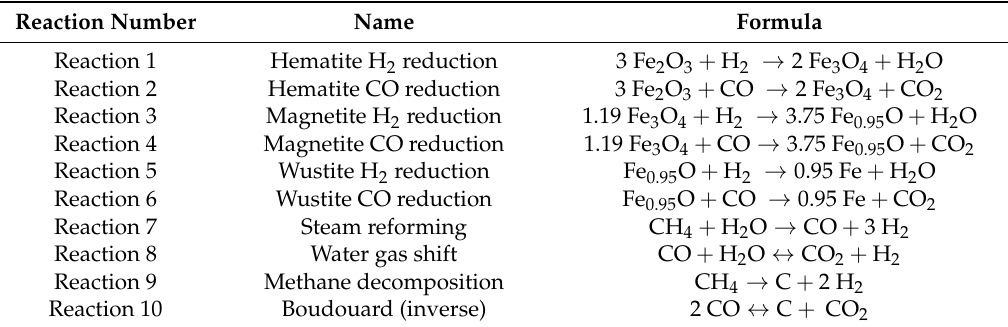
Table A1. Considered